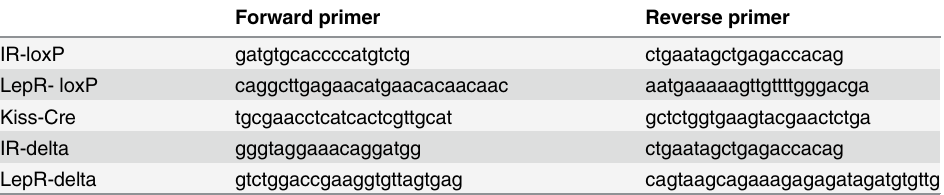
Table 1. Genotyping primer